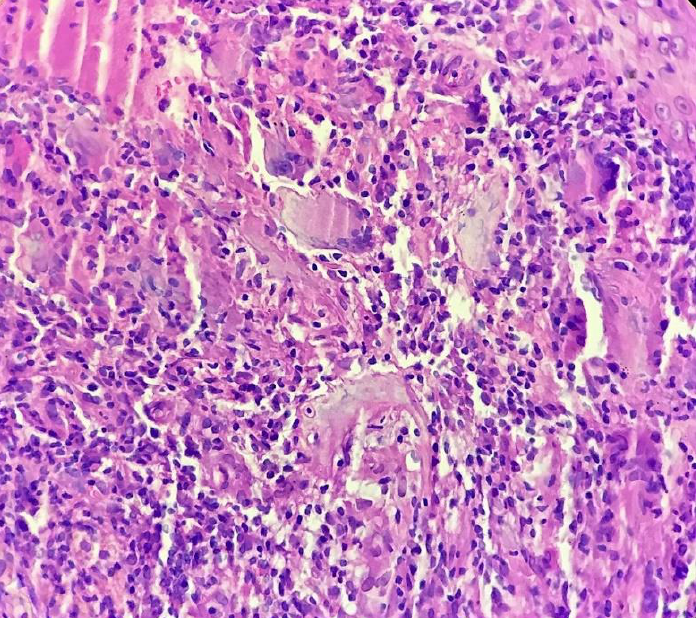
Figure 4. Tuberculoid granuloma in upper dermis comprised of epithelioid cells, giant cells and surrounded by lymphocytes (H&E × 400).